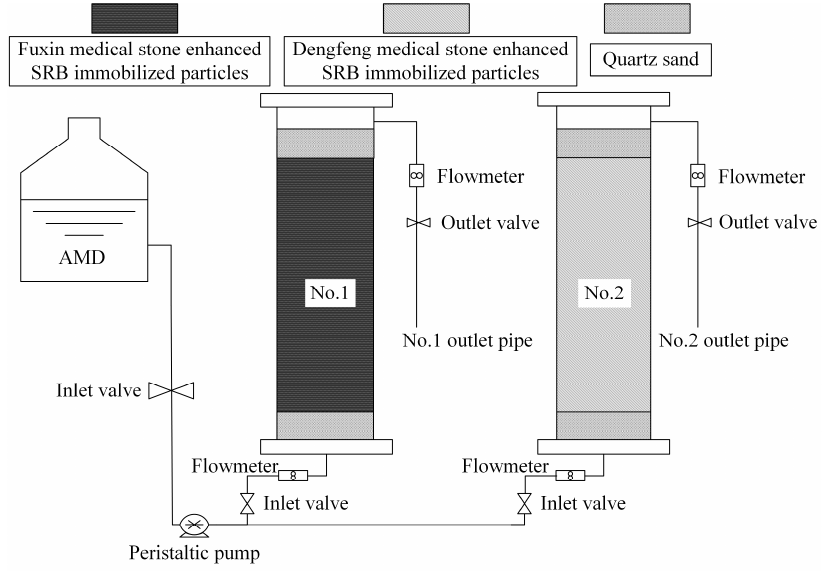
Figure 1. System diagram of dynamic testing device.